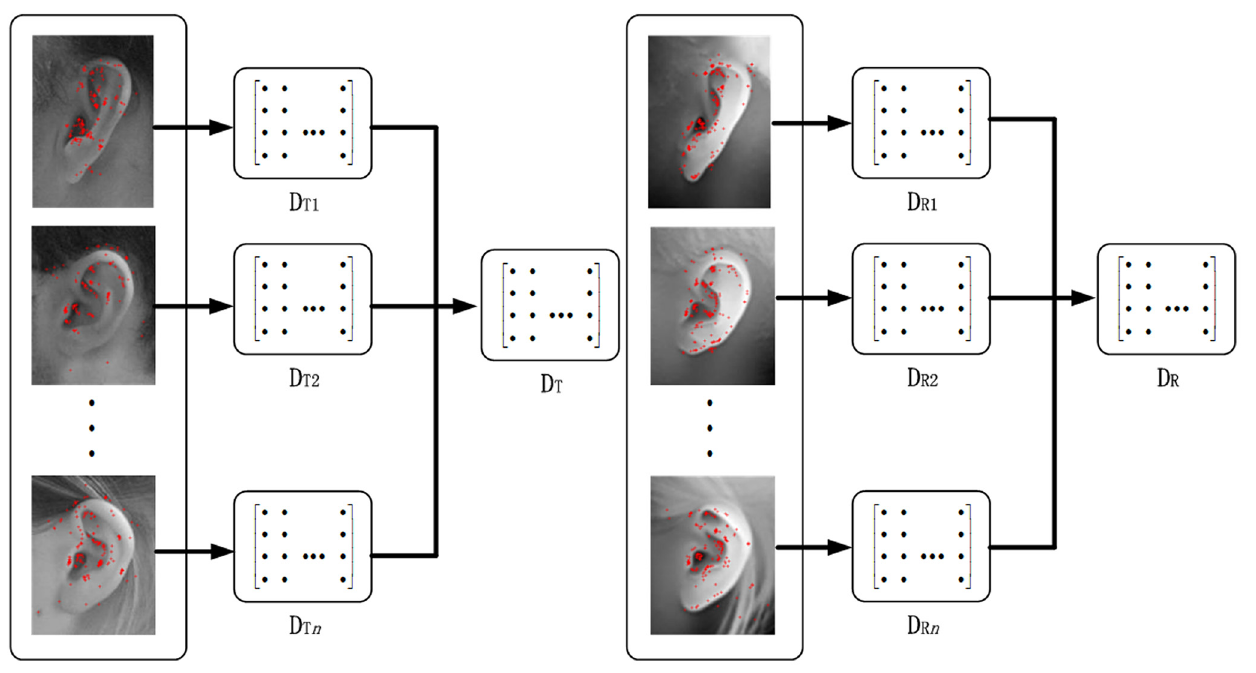
Fig 5. Illustration of the construction of hybrid MKD-SRC